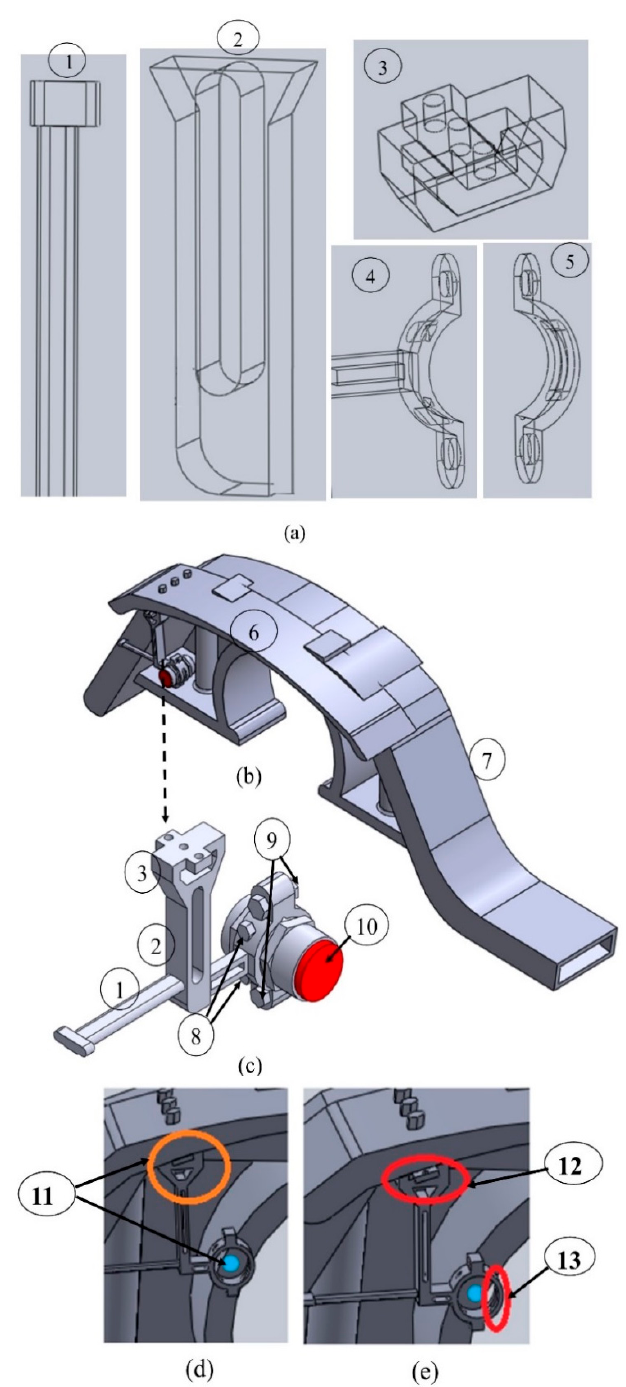
Figure 5. ( a ) CAD model of the parts of the sensor holding fixture, ( b ) CAD model sensor holing fixture assembled on the bogie frame through bogie fender. ( c ) CAD model of sensor holding fixture (complete view). ( d ) Calibrated sensor holding fixture. ( e ) Uncalibrated sensor holding fixture.